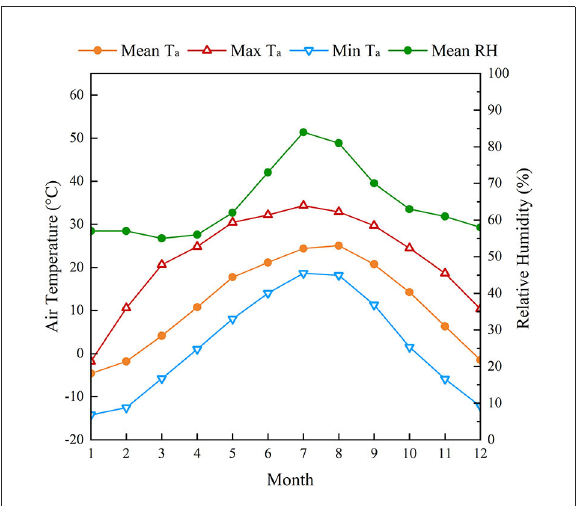
FIGURE1 Monthly mean, maximum, and minimum air temperature ( T a ) and mean relative humidity (RH) in Dalian, China, from 2011 to 2021